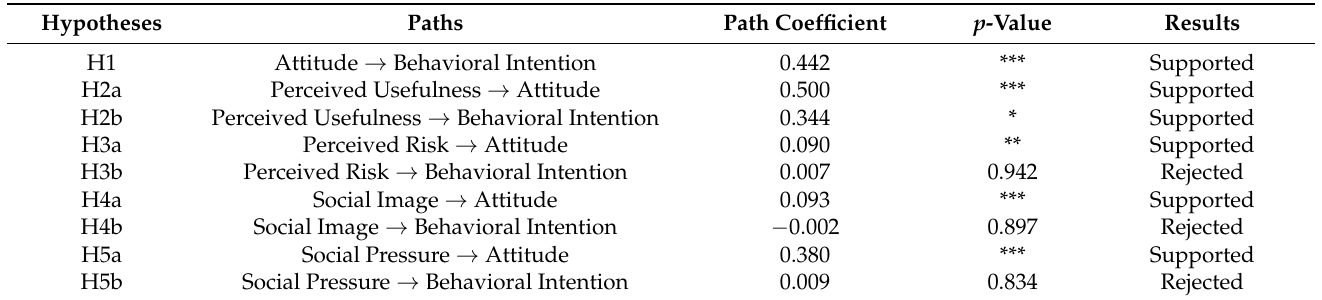
Table 4. Results of Hypothesis Testing.